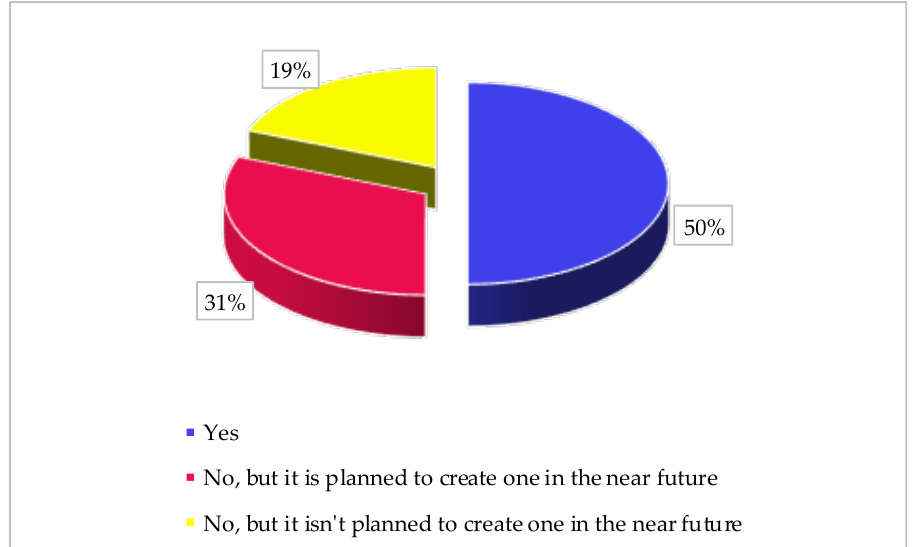
Figure 7. Presence of a risk register in 50 Polish companies. Source: authors’ study.